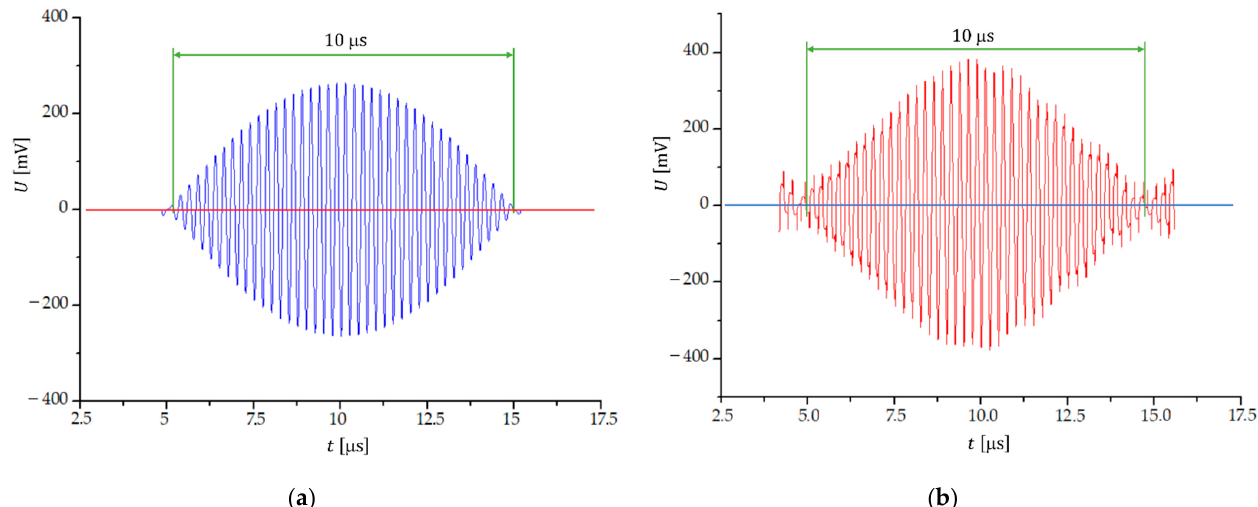
Figure 4. One beat period of the beat signal, when the frequency difference of two ( a ) sinusoidal and ( b ) rectangular signals is 100 kHz; f 1 = 3.95 MHz and f 2 = 4.05 MHz.